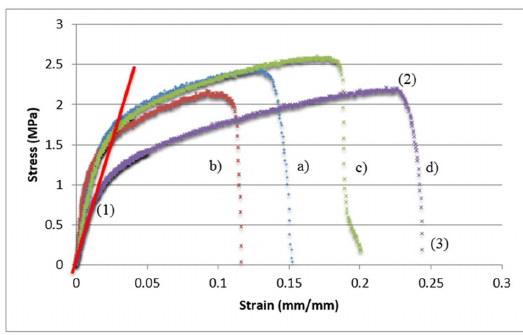
Figure 8. Typical stress‑ strain curve of : (a) PLA pure; (b) PLA/ SBA‑15 (0.05 wt%) (c) PLA/SBA‑15 (0.10 wt%) and (d) PLA/ SBA‑15 (0.15